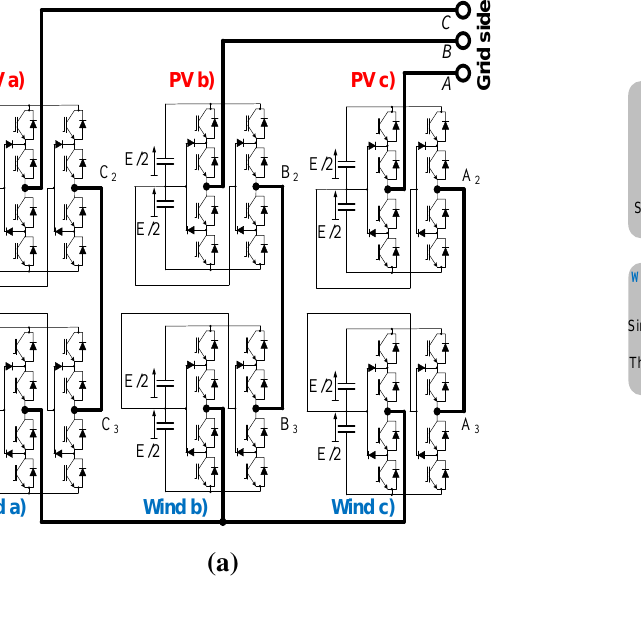
Figure 2. Single-phase H-bridge and studied topology comparison: P V means photovoltaic source; W ind means wind source. ( a ) Cascaded H-bridge VSCwith 3L-neutral point clamped (NPC) [8]; ( b ) the studied topology proposed in